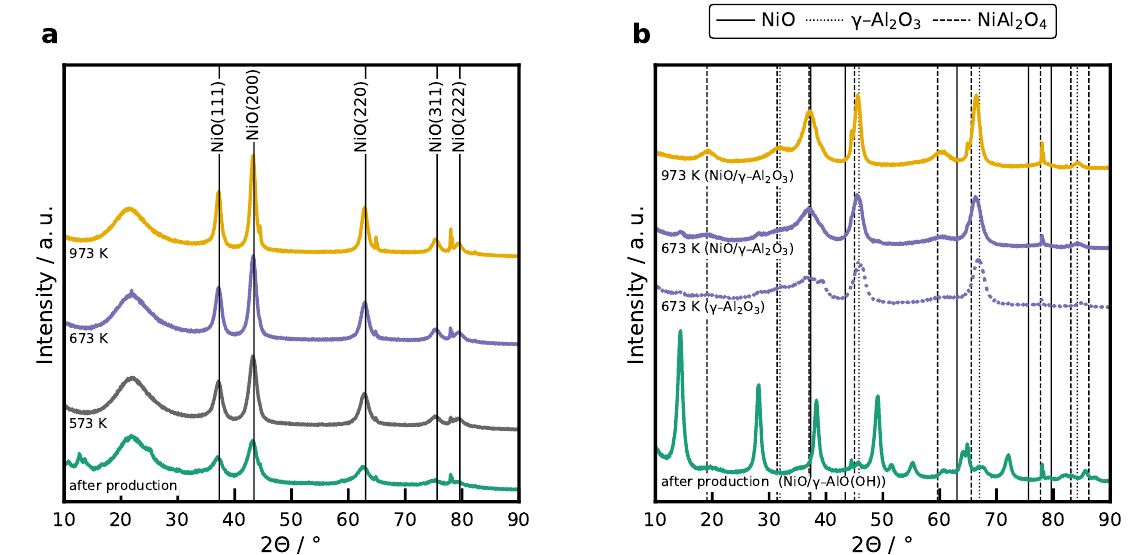
Figure 4. ( a ) XRD patterns of the 20wt% Ni/SiO 2 catalyst with BB(20) after production, and after calcination at different temperatures. The broad reflection at 2 Θ = 22° is assigned to amorphous silica and the reflections at 38.2, 44.6, 65.0, 78.0, and 78.1° are caused by the Al sample holder. ( b ) XRD patterns of the 10wt% Ni/Al 2 O 3 catalyst after production, and after calcination at 673K and 973K for 4h. Reflections for the boehmite structure obtained after production is provided in Figure